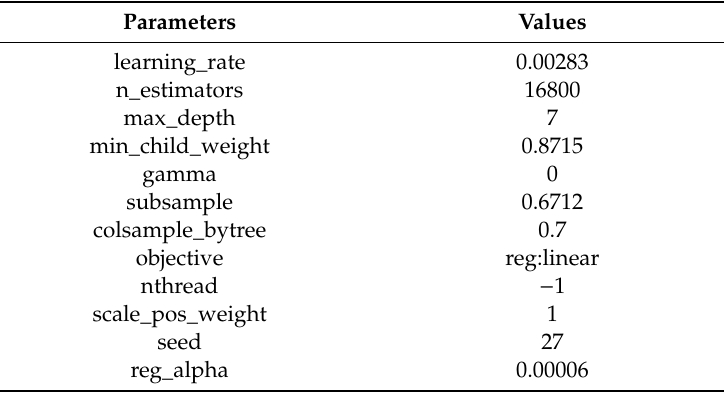
Table 1. Tuned hyper-parameters in the XGBoost model.